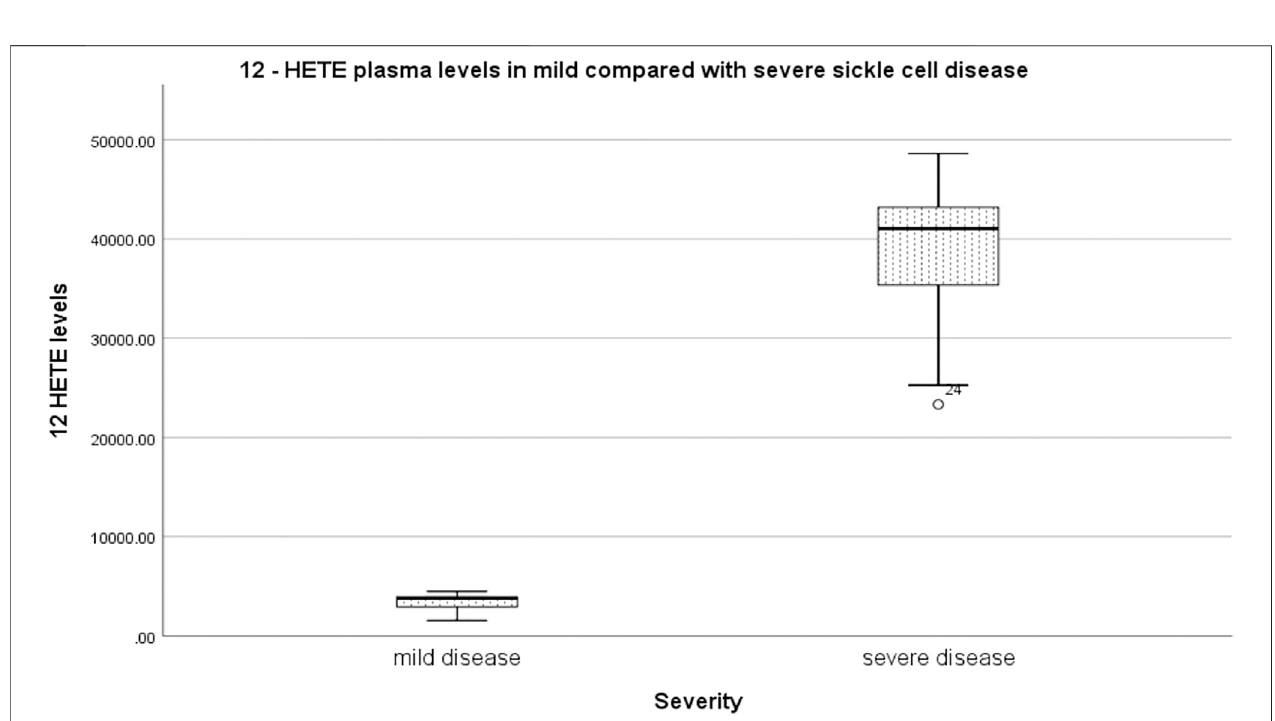
FIGURE1| Variationofplasmaconcentration(pg/ml)of12-HETEwithSCDseverity.Thethickhorizontallineineachboxrepresents themedian12-HETEvaluefor the disease severity group.